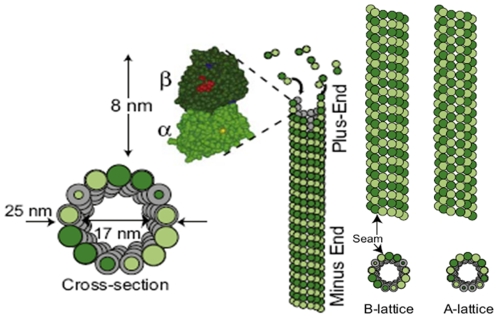
Geometry of a microtubule [13].